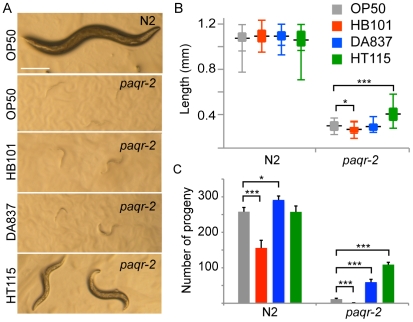
Partial rescue of paqr-2 mutant growth at 15°C and brood size at 20°C using different diets.(A) Shows wild type or paqr-2 worms grown at 15°C for 6 (N2) or 11 (paqr-2) days using various types of bacteria as food sources. Note how HT115 visibly rescues the growth of the paqr-2 mutant. Scalebar is 250 µm and applies to all images. (B) Length at day 6 for wild type or paqr-2 mutants grown at 15°C on the indicated food sources; boxes span from the 25th to the 75th percentile, outer brackets indicate the range of length and the horizontal black line indicates the mean length for each genotype (n≥19). (C) Shows the average brood sizes obtained for wild type or paqr-2 worms grown at 20°C on the indicated food sources, and the error bars show the sem. *p<0.05, **p<0.01, ***p<0.001.